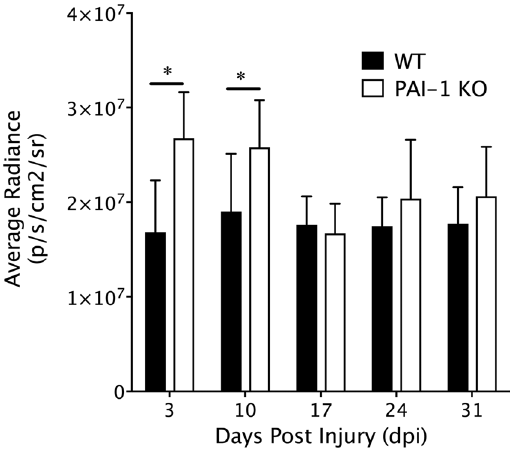
Figure 5. MMP activity is enhanced early after deep digital flexor tendon injury in the PAI-1 KO mice compared to WT. In vivo matrix-metalloprotease (MMP) activity, measured longitudinally using fluorescent IVIS imaging following IV delivery of MMPSense 750FAST and quantified in region of interest encompassing the injured paw as photon counts per second per unit area. MMP imaging was performed on days 3, 10, 17, 24, and 31 post injury. Data are presented as mean ± standard deviation. Asterisks indicate significant differences between WT and PAI-1 KO (p <